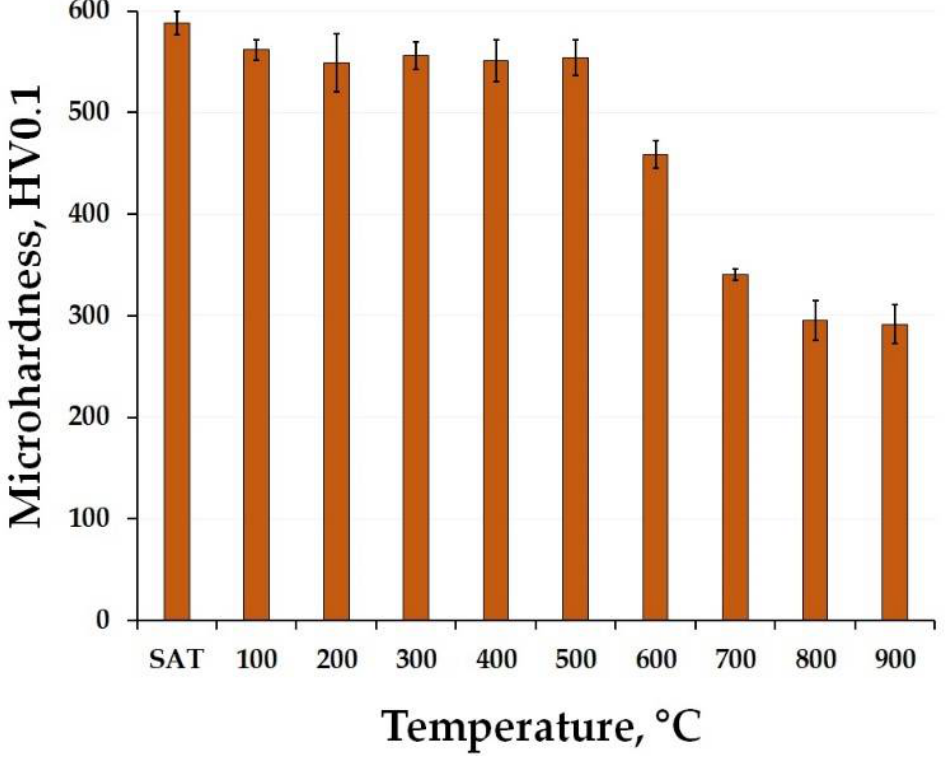
Figure 2. Microhardness of the as-heat-treated 1.2709 maraging steel as a response to exposure to different temperatures with a total dwell time of 2 h.